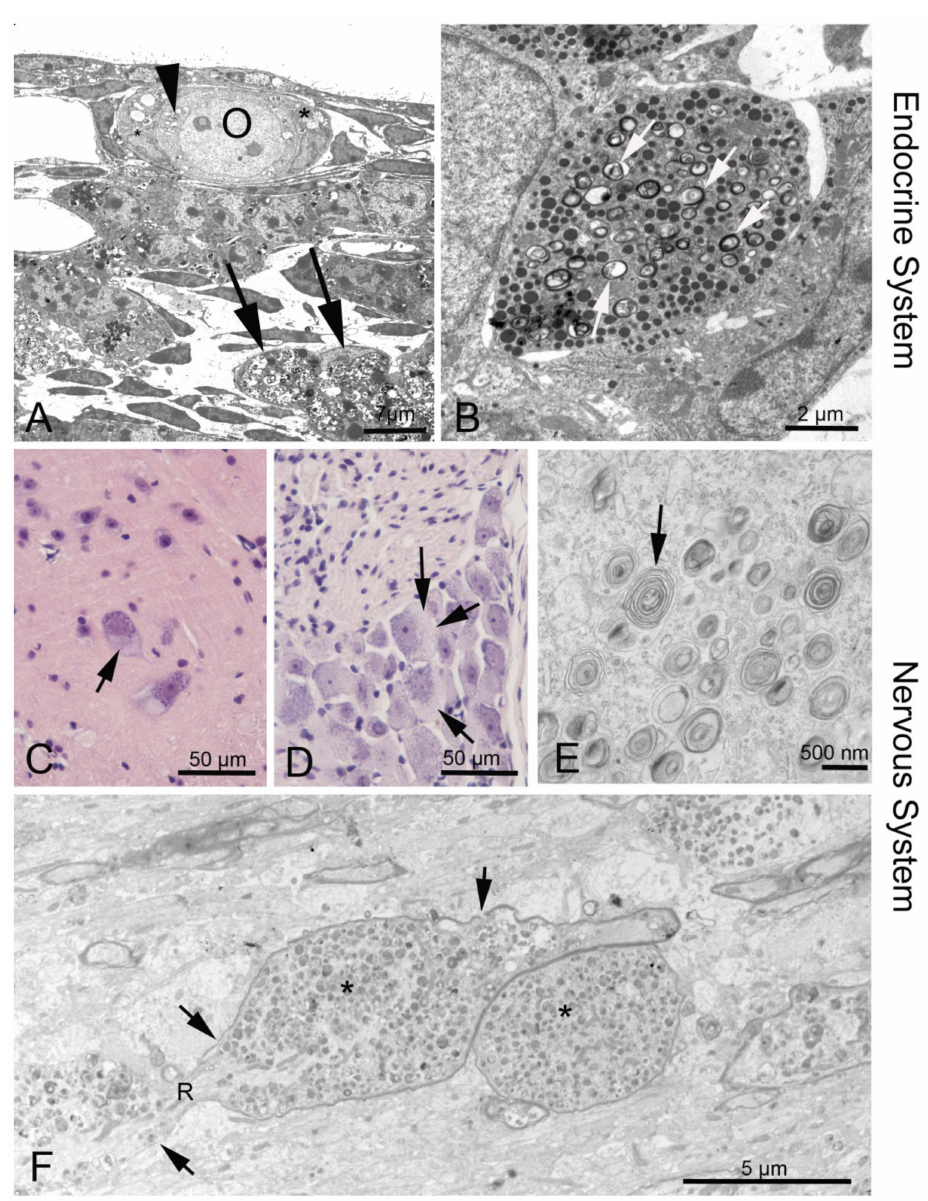
Figure 2. Phenotypes of NPC1 in the endocrine and nervous system. ( A ) Ovary of an Npc1 − / − mouse. The oocyte (O) contains enlarged endoplasmic reticulum (ER) with myelin-like deposits (arrowhead), as does the surrounding follicular epithelial cell (asterisk). Large accumulations are seen in a macrophage (arrows). ( B ) Neuroendocrine cell in the anterior pituitary. Arrows point at myelin-like inclusions between secretory vesicles. ( C ) Some alpha motor neurons in the anterior horn of the spinal cord are filled with light material replacing the darker perinuclear Nissl substance of the endoplasmic reticulum. ( D ) Similar damage is seen in dorsal root ganglion cells (arrows). ( F ) Corpus callosum: A longitudinal nerve fiber is enlarged and congested by autophagosome content (asterisks) that interrupts the continuity of neurofilaments and neurotubuli. The myelin sheath (arrows) has also thinned and disintegrated. R, node of